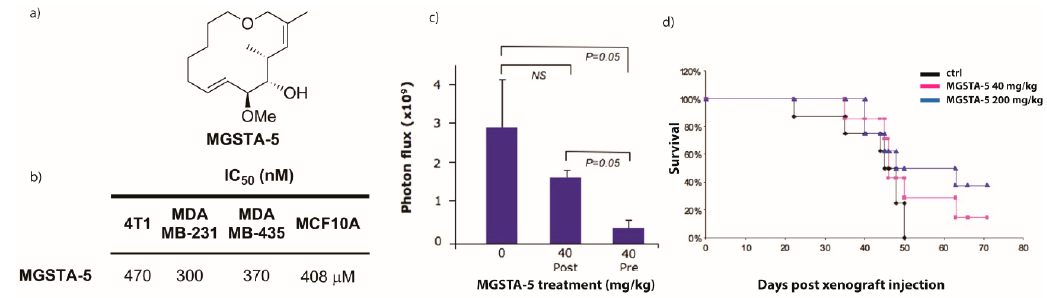
Figure 5. ( a ) Structure of MGSTA-5 ; ( b ) Chamber cell migration assay; ( c ) MGSTA-5 treatment